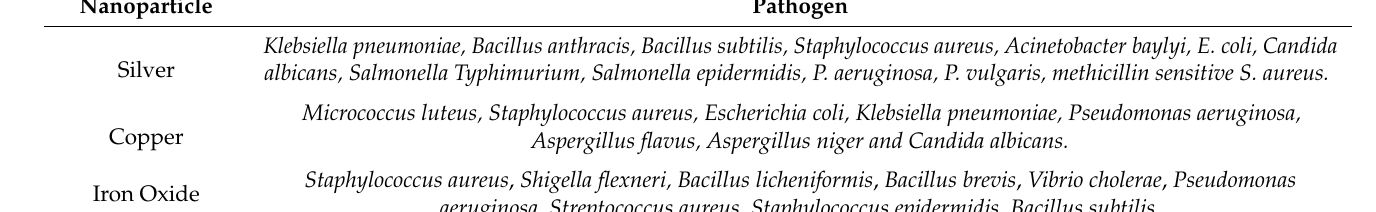
Table 5. Silver, copper and iron oxide nanoparticles and some of the pathogens they are effective against (adapted from [35,106,113]).